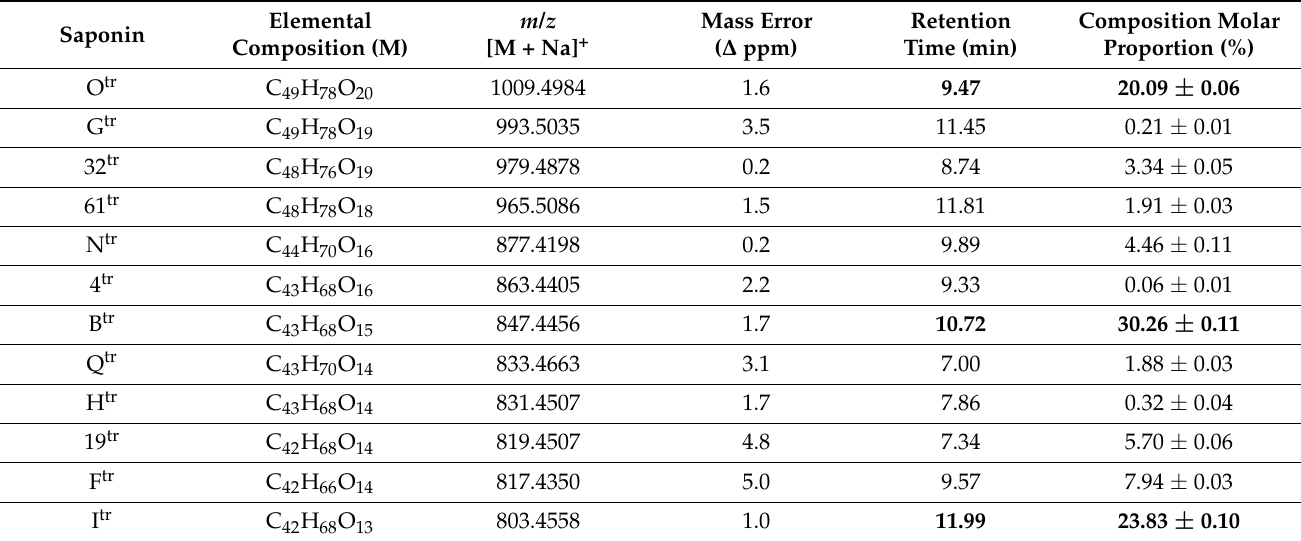
Table 3. Transesterification (MeOK 1 M—MeOH anh —N 2 —60 ◦ C—60 min) of Chenopodium quinoa husk bidesmosidic saponins: the elemental compositions of saponin ions are determined by MALDI- HRMS, and the molar proportions (%) of all the saponin ions are estimated based on the LC-MS signal integration.